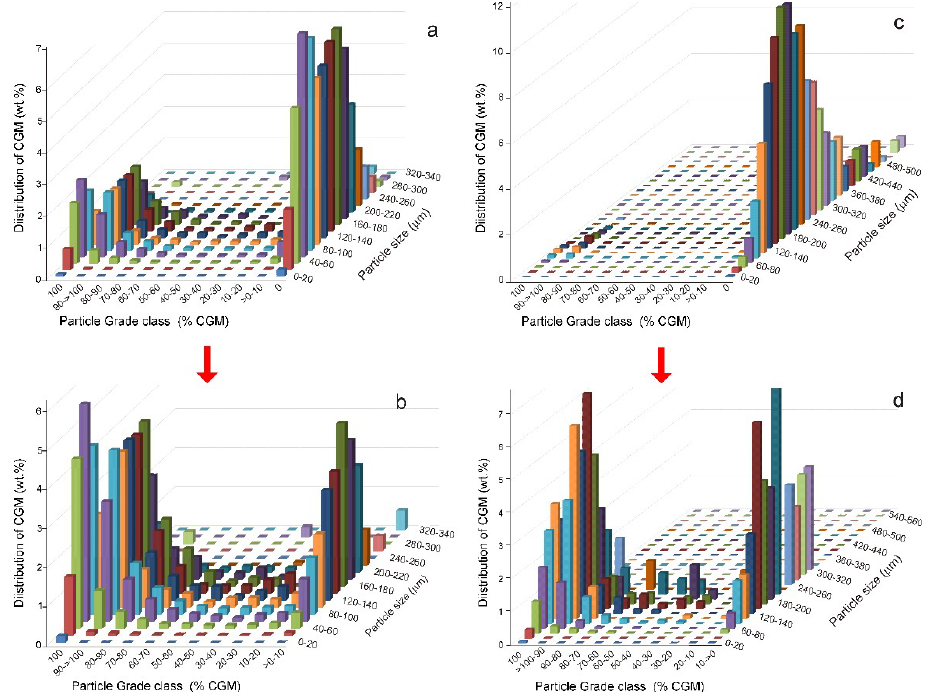
Figure 15. Distribution of cassiterite in the concentrated materials according to particle size and cassiterite grade classes. ( a ) Leucogranite taking all of the particles into account; ( b ) detail where the zero grade particles were not considered; ( c ) tailings taking all of the particles into account; and ( d ) detail where the zero grade particles were not considered.